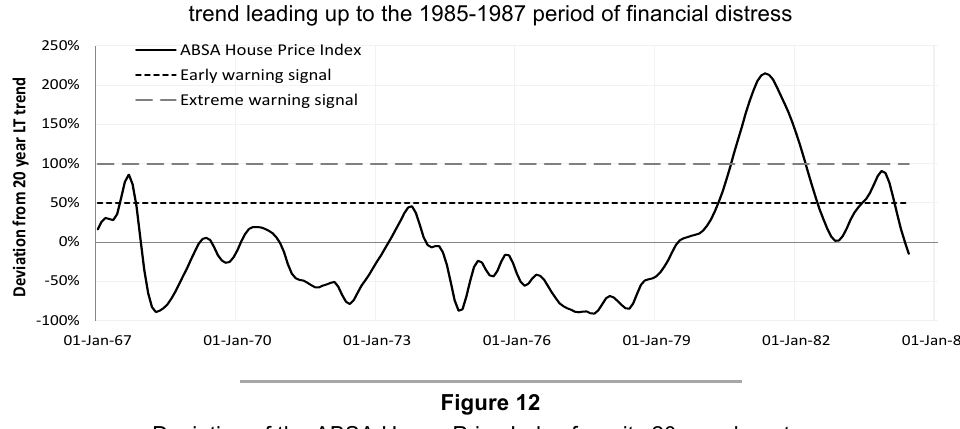
ABSA house price index Early warning signal Extreme warning